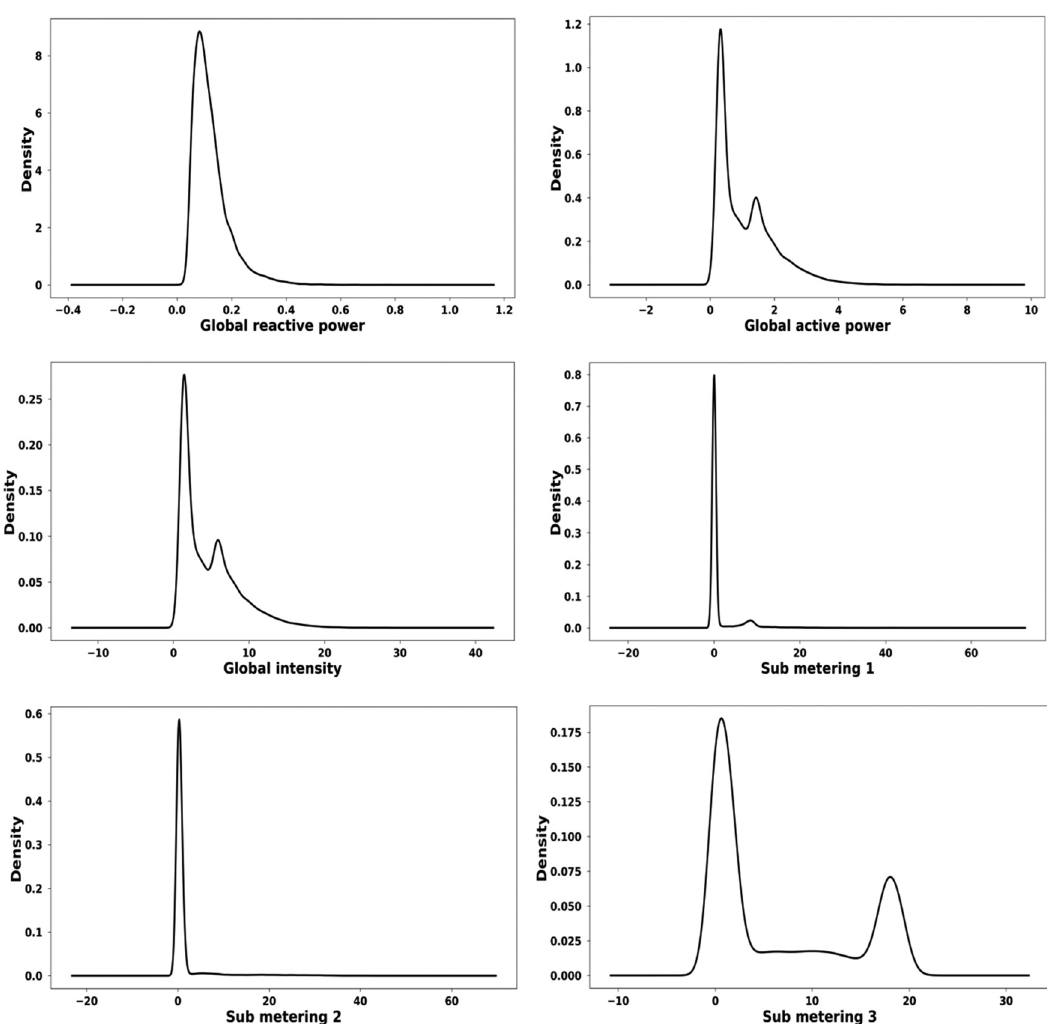
Figure 7: Probability density function of IHEPC